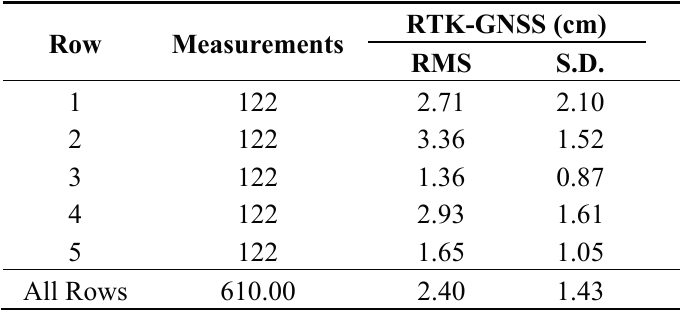
Table 3. Statistics for the GNSS receiver using RTK correction signals on the autonomous tractor in